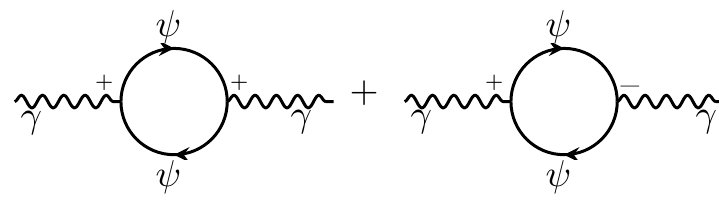
Figure 4 . The retarded self-energy diagram of the photon from charged-fermion